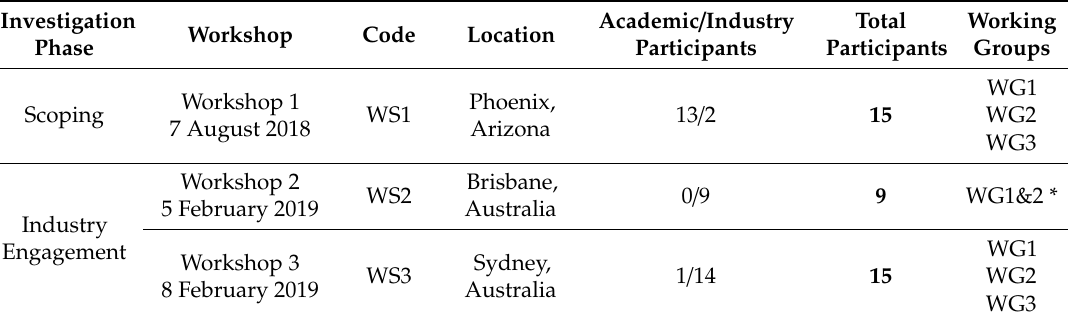
Table 1. BPD workshops: meta-data